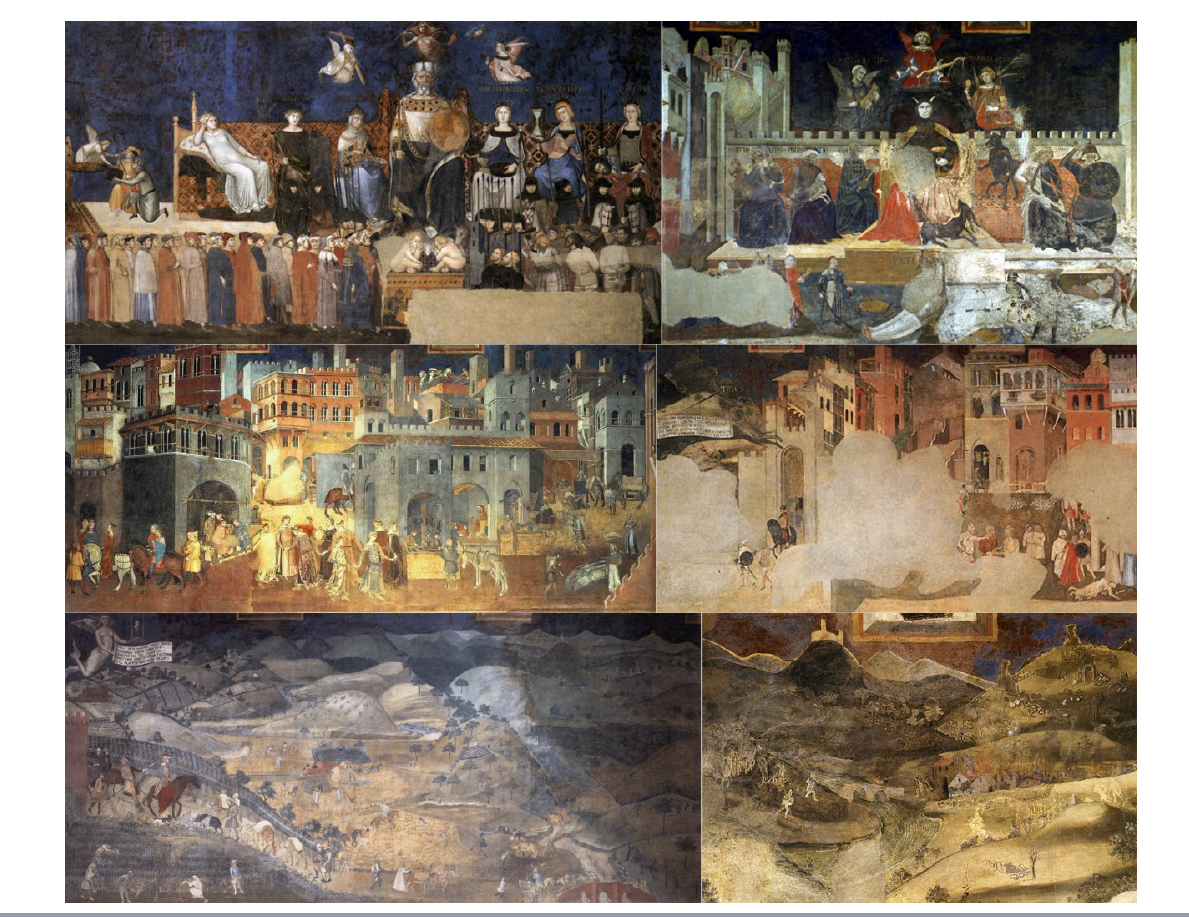
Fig. 1 . The Lorenzetti frescoes in the Palazzo Pubblico in Siena, Italy. From top to bottom: allegories of good and bad government, followed by their respective effects on city and country (source: Web Gallery of Art, http://